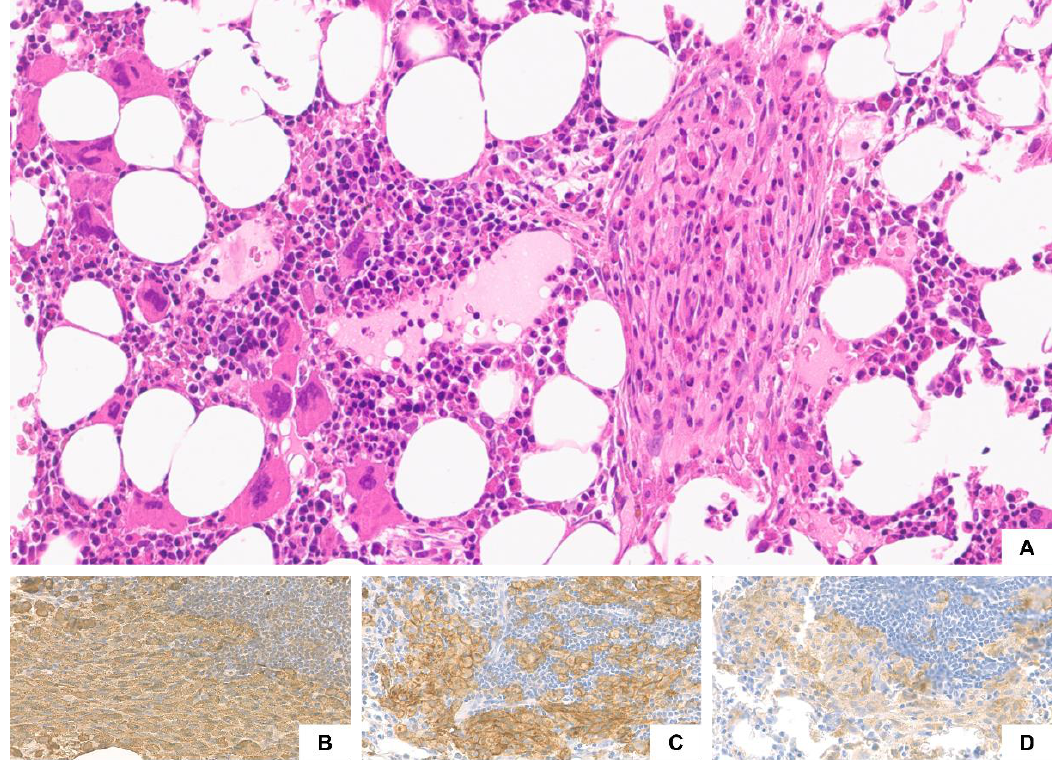
Figure 2. Case 2. A dense aggregate of spindle-shaped MCs admixed with eosinophils in the BM (on the right). Megakaryocytes were increased in number with several enlarged forms and loose clustering (on the left) ( A , hematoxylin and eosin, ×200). MCs positively staining for tryptase ( B , ×400), CD25 ( C , ×400), and CD30 ( D , ×400).